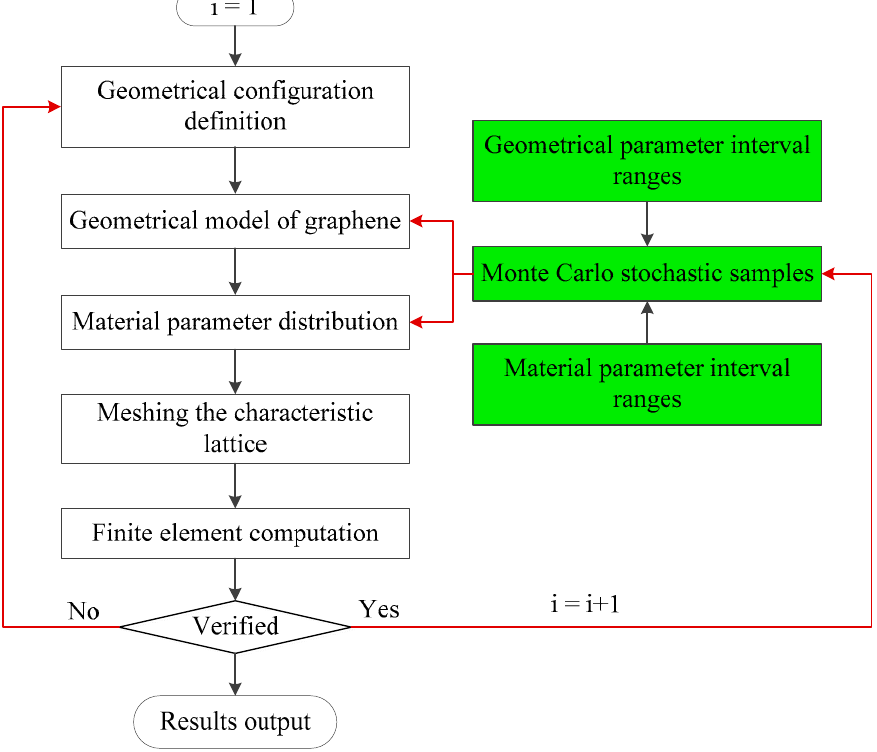
Figure 5. The flowchart of resonant frequency computation by the finite plane element model based on the Monte Carlo stochastic simulation.